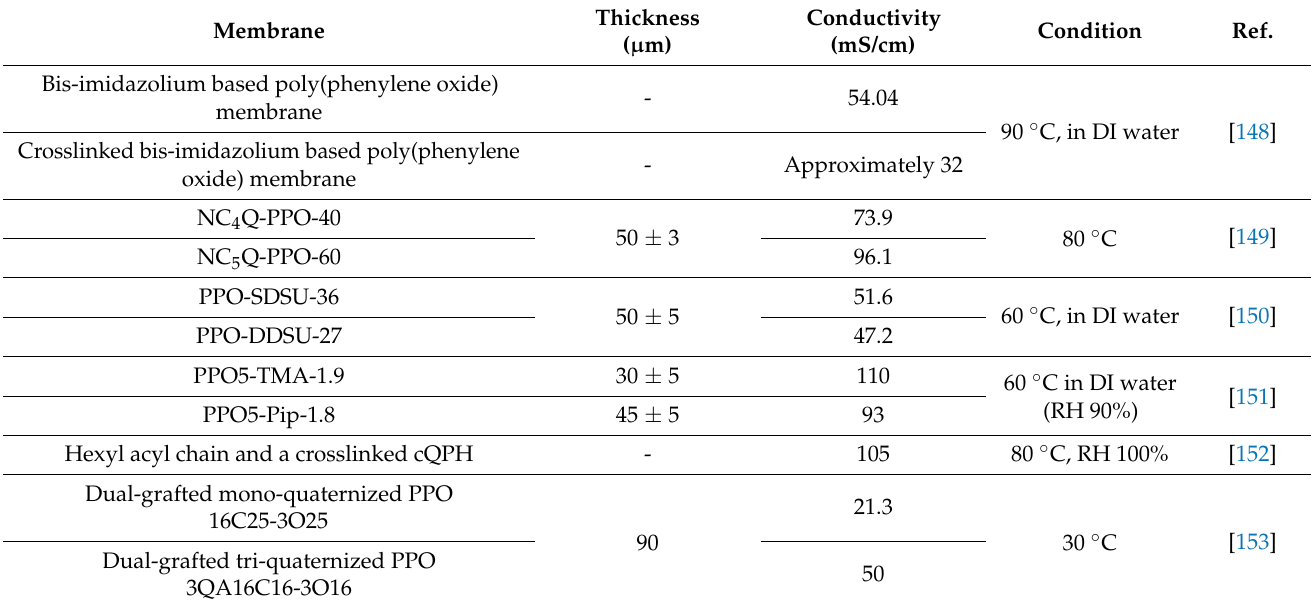
Table 7. Ionic conductivity of polyphenylene-based